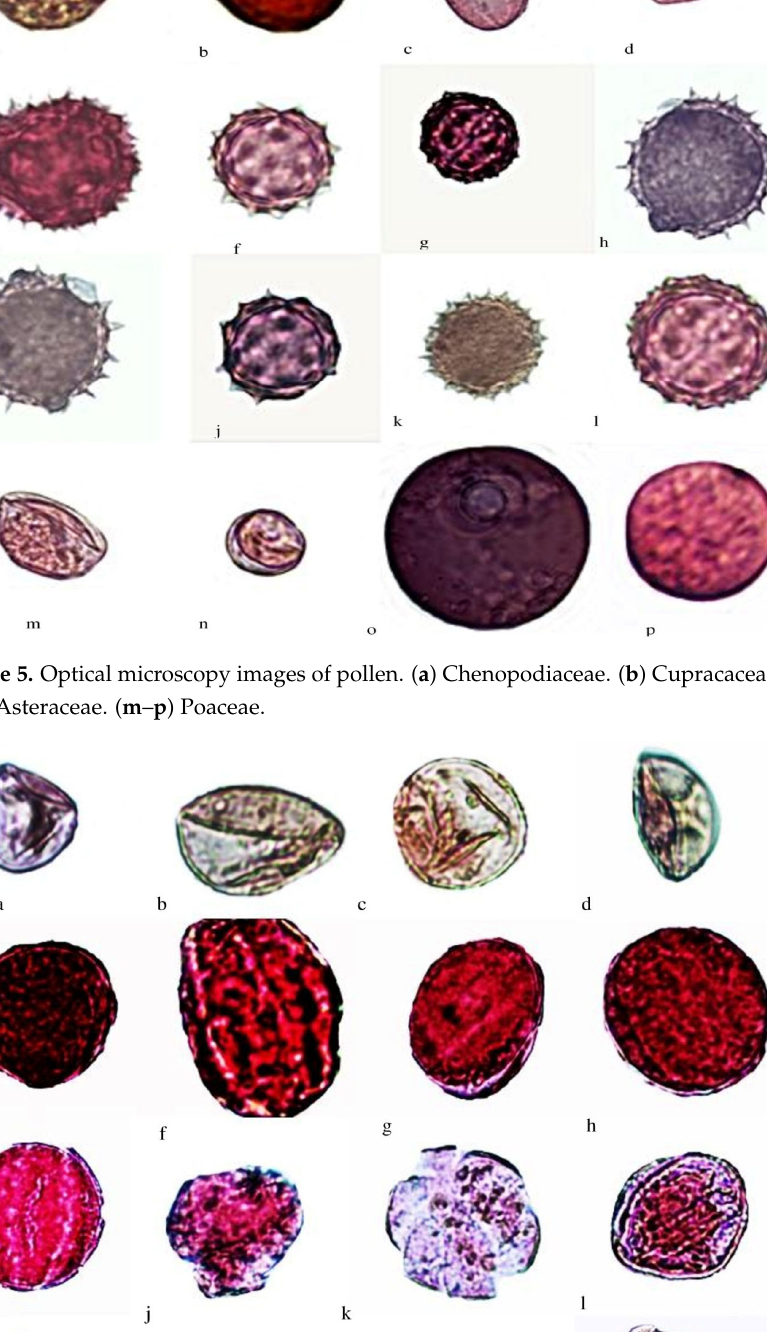
Figure 6. Optical microscopy images of pollen. ( a – d ) Poaceae. ( e – p ) Lamiaceae.